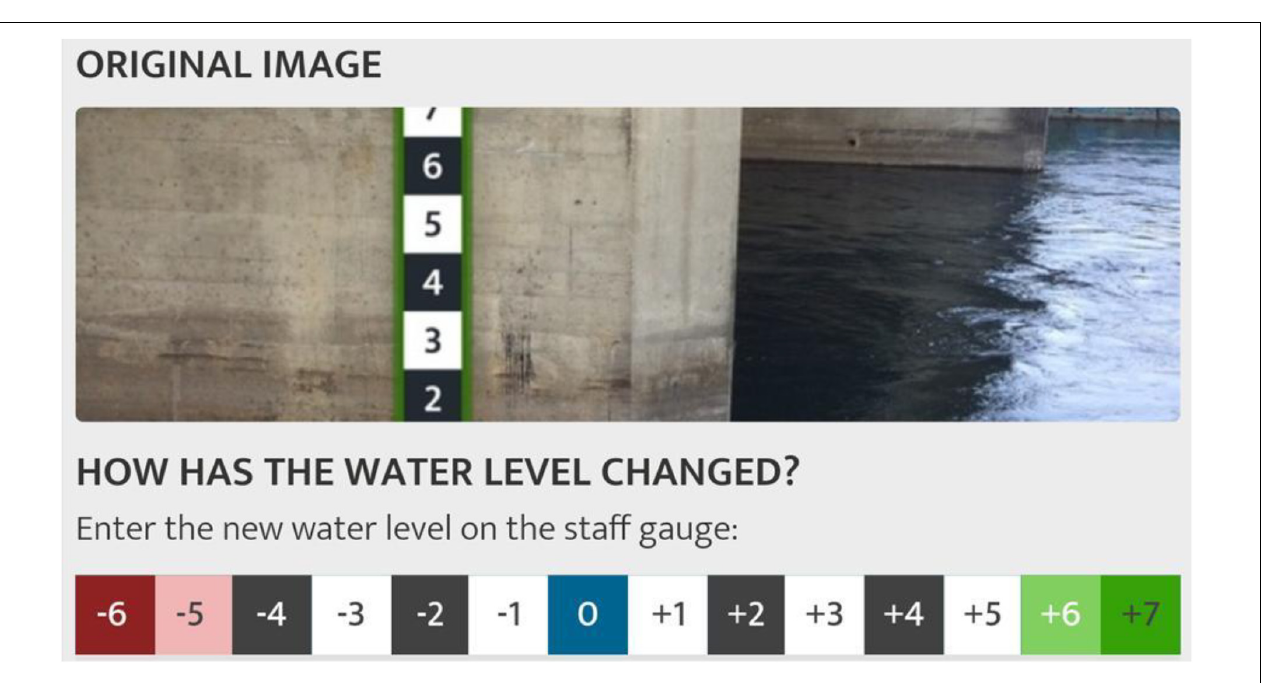
FIGURE 2 | The horizontal version of the staff gauge at the “Update Spot” interface as selectable buttons to report the new water level class observation. Design/author: Philipp Hummer, SPOTTERON Citizen Science, www.spotteron.net.